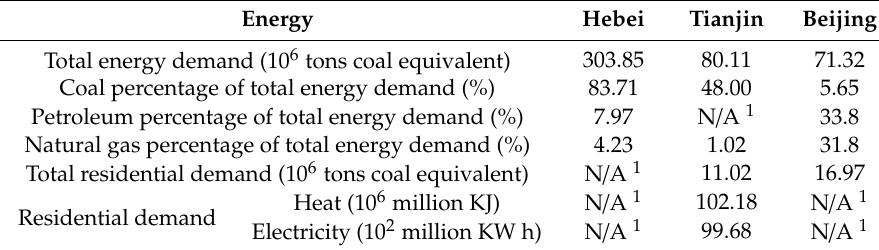
Table 14. Energy demand of the B-T-H region in 2017